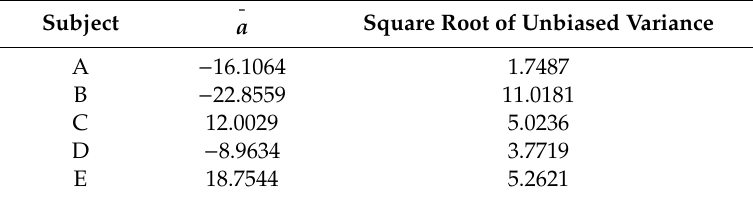
Table 3. Average estimation results for the single regression coe ffi cient and the square root of the unbiased variance. The average a from a k ( k = 1, 2, ... , 6) determined using Equation (3) and the square root of the unbiased variance of a k for each subject are